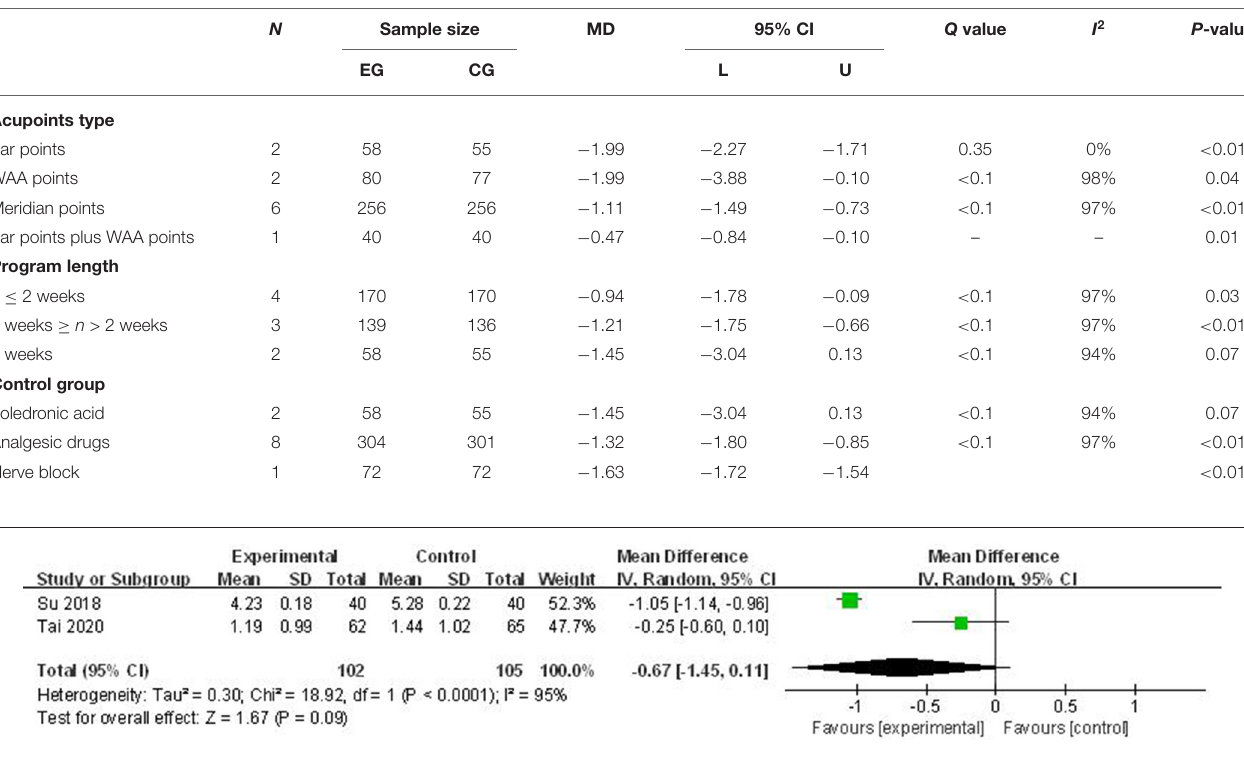
TABLE 3 | Results of subgroup analyses of pain score.